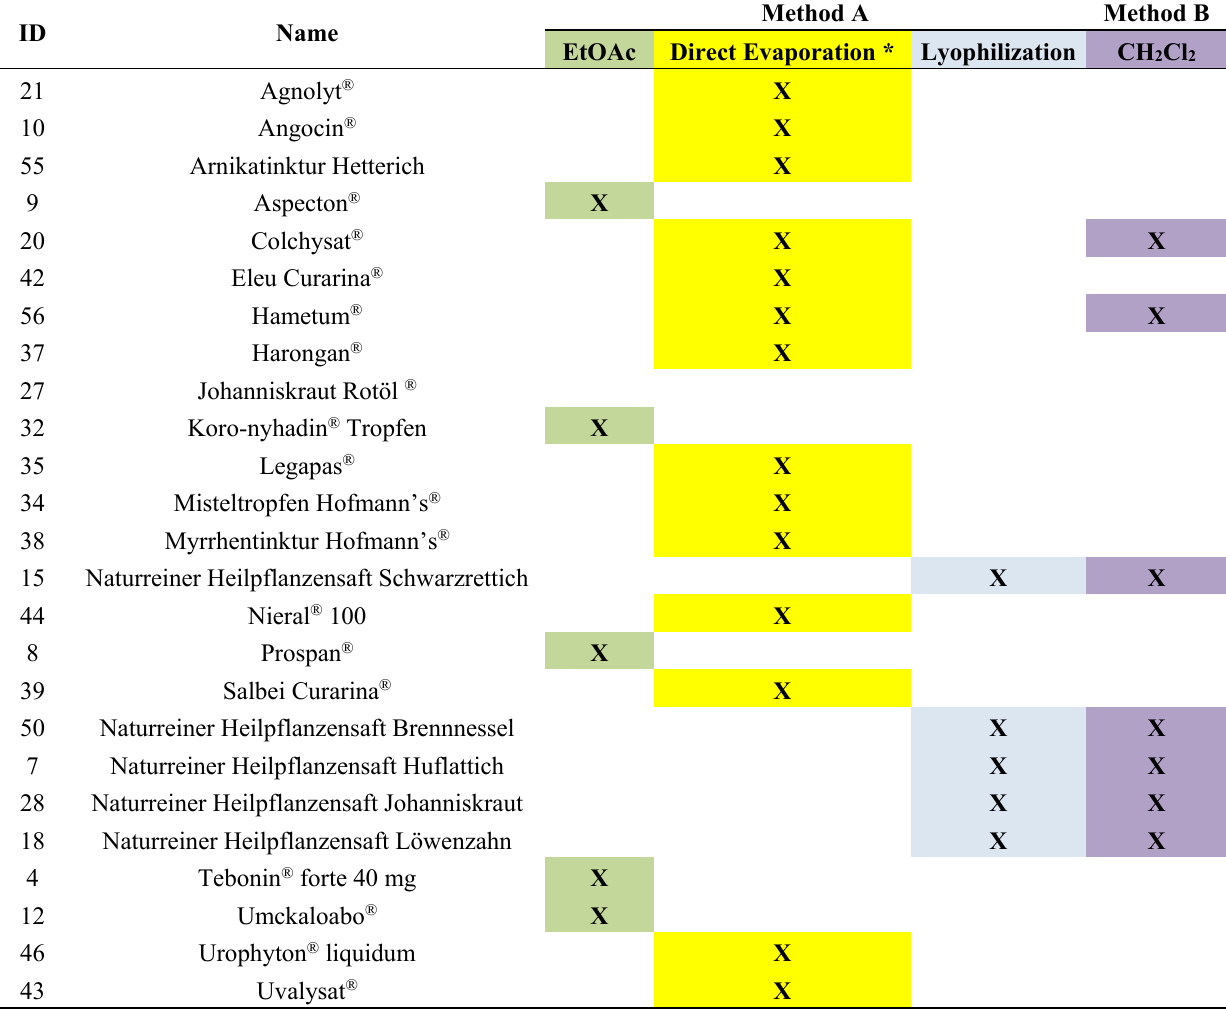
Table 2. Extraction methods used for liquid dosage